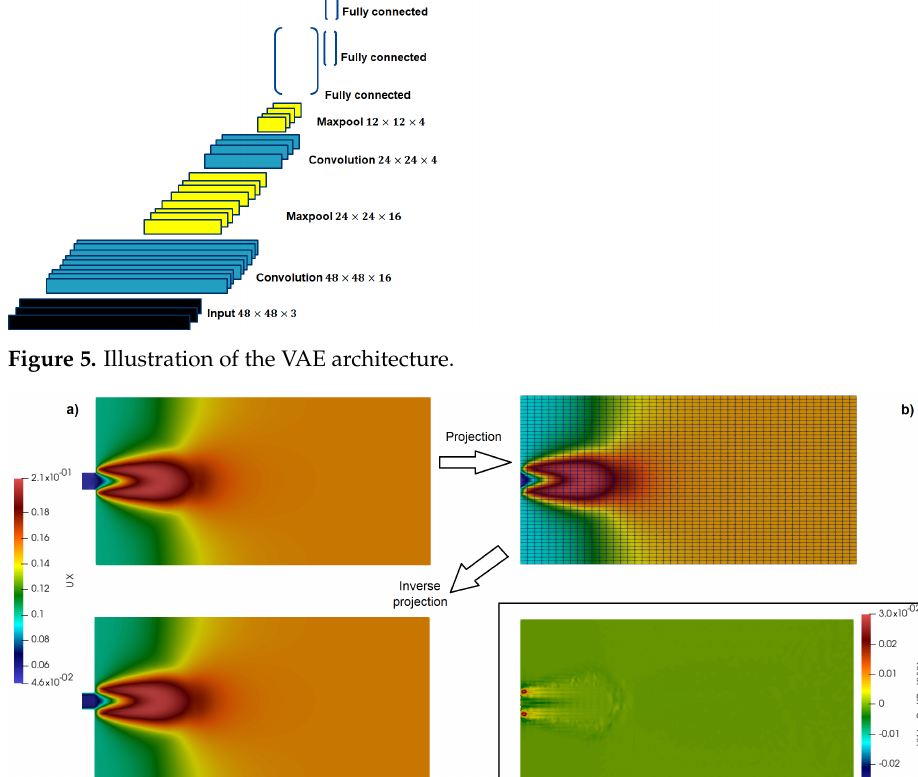
Figure 6. Illustration of the projection and inverse projection operations: ( a ) example of a YALES2 solution on the unstructured mesh; ( b ) projection of ( a ) on the 48 × 48 Cartesian mesh; ( c ) inverse projection of ( b ) on the unstructured mesh; ( d ) difference between ( a , c ), which corresponds to the errors introduced by both the projection and inverse projection